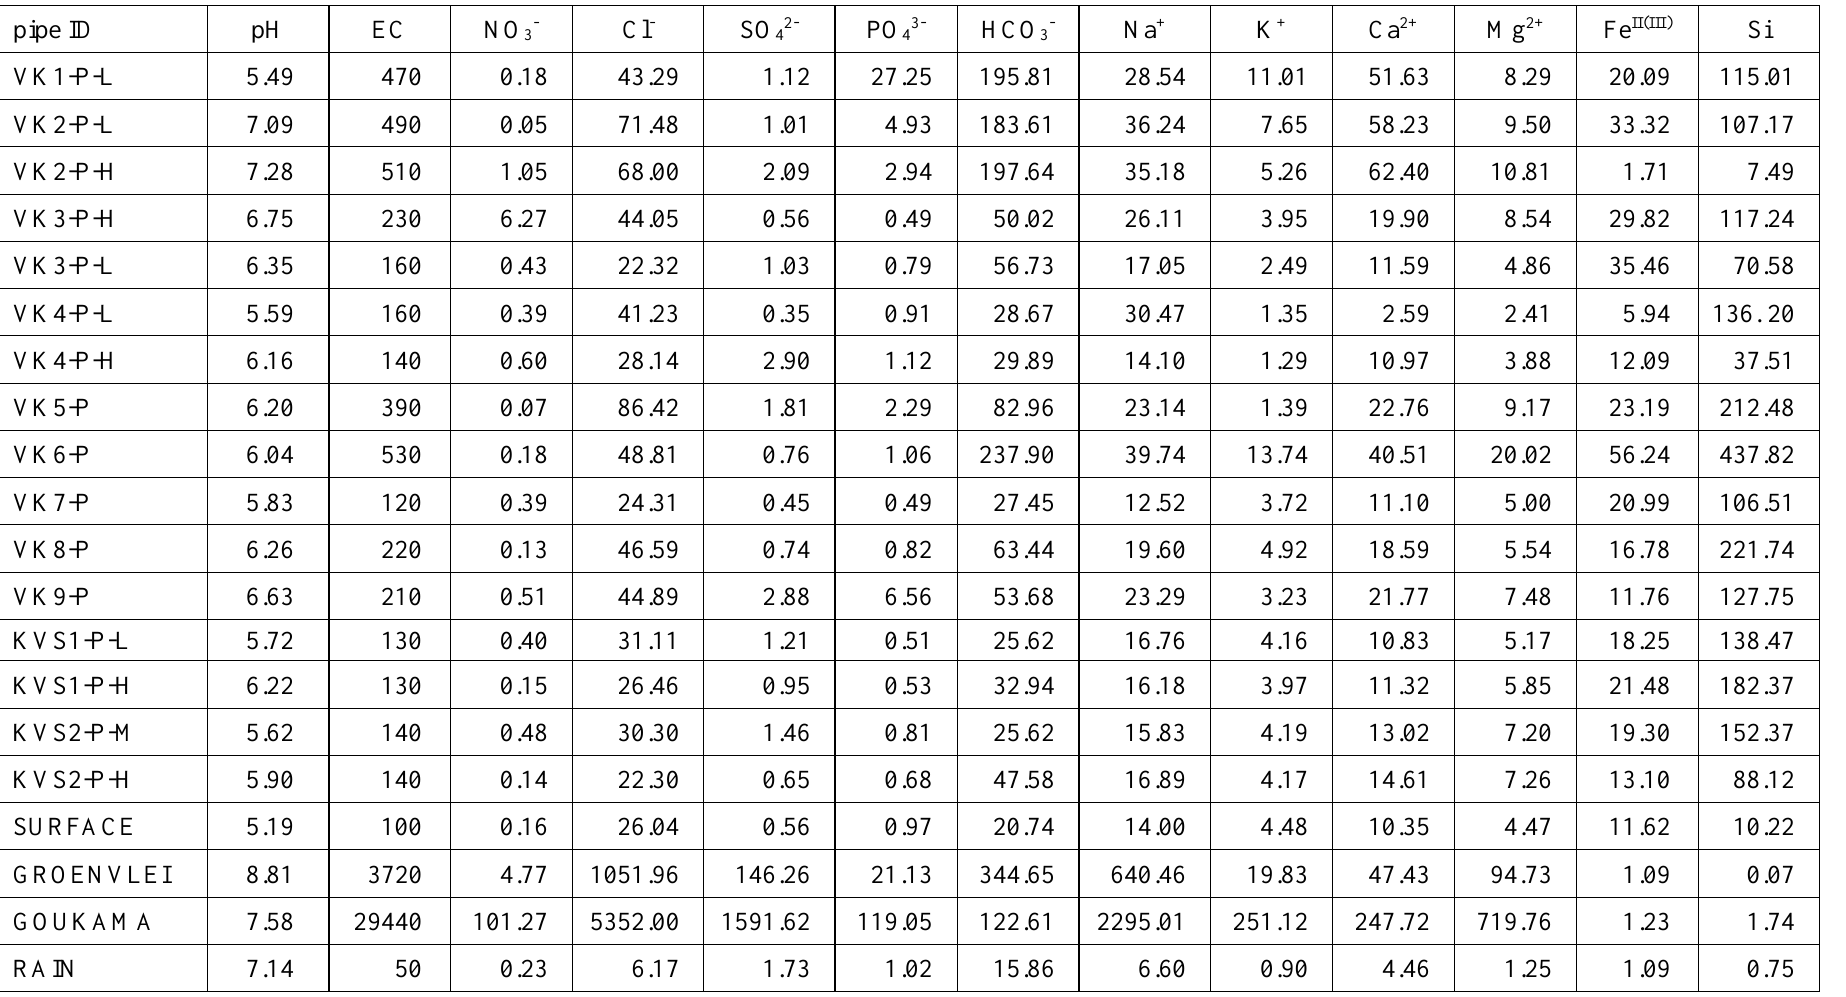
Table A2. pH, EC, ions and nutrients (in mg L -1